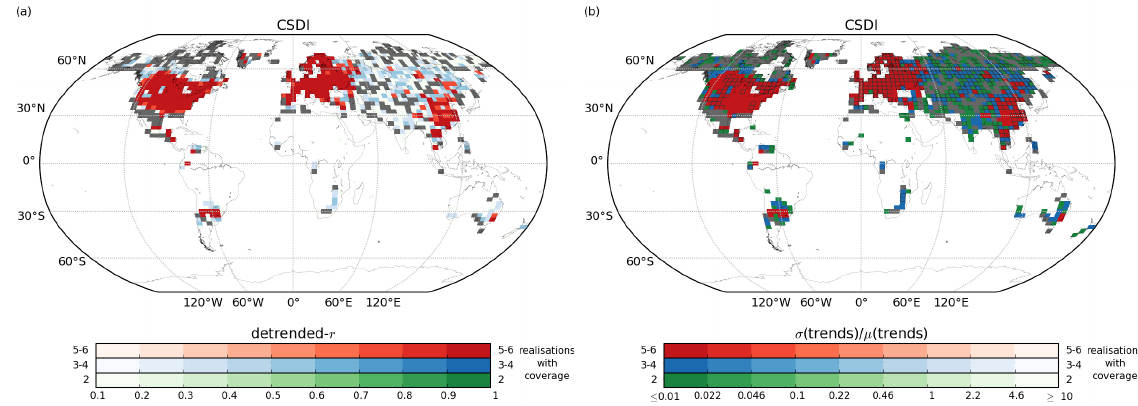
Figure 8. (a) The mean correlation coefficient of the detrended time series, r with HadEX2 for all the grid boxes and (b) the standard deviation of the trends divided by the mean trend ( σ/µ ) calculated for the period 1951–2010 for CSDI and the number of stations per grid box. Green grid boxes are those where two of the six possible choices of stations per grid box result in a value, blue where three to four, and red where five to six. Note that the HadEX2 method does not require any stations to be present within a grid box for a value to be calculated. For further details see Fig. 5.